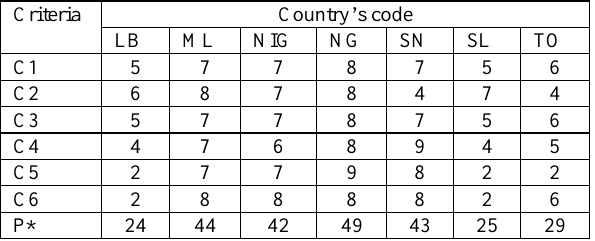
Table 2b. : Geospatial performance of Member States (2)